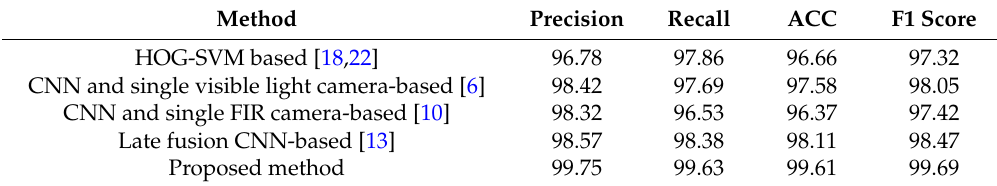
Table 9. Comparisons of classification accuracies with original DVLFPD-DB1 based on precision, recall, accuracy, and F1 score (unit: